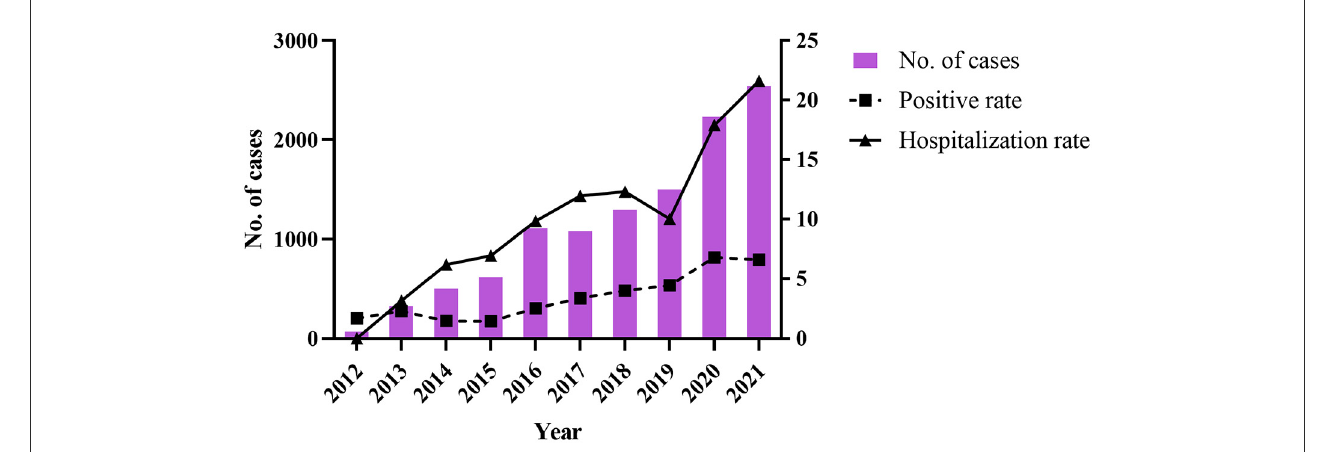
FIGURE1 The change of number of cases, positive rate, and hospitalization rate of Salmonella during 2012–2021.